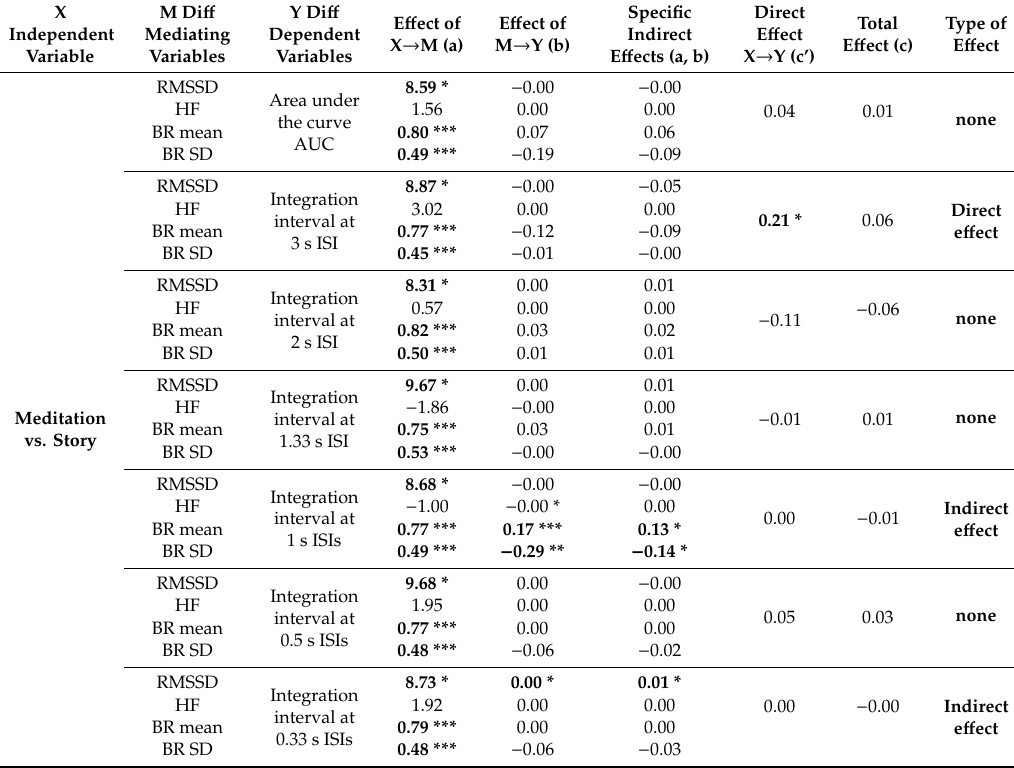
Table 3. Summary of mediation results for the metronome task with the whole sample ( n = 84). X Independent